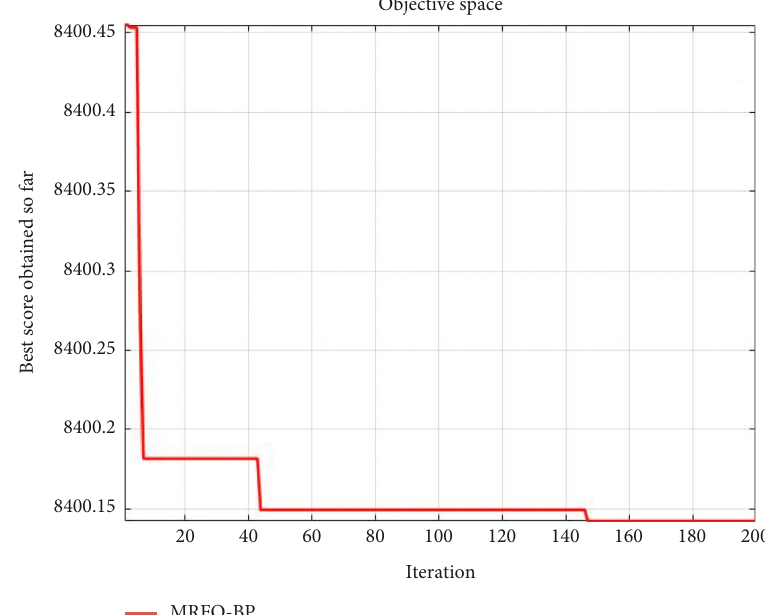
Figure 21: Historical optimal position curve of the middle of the spiral casing (comparative